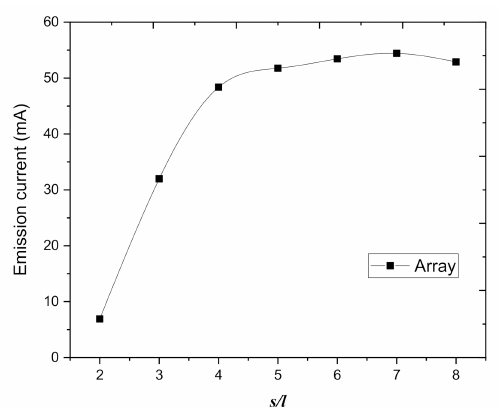
Figure 6. The relation between normalized spacing and the field emission current of the graphite sheet at the center of the array. ( U = 200 V, d = 2.75 µ